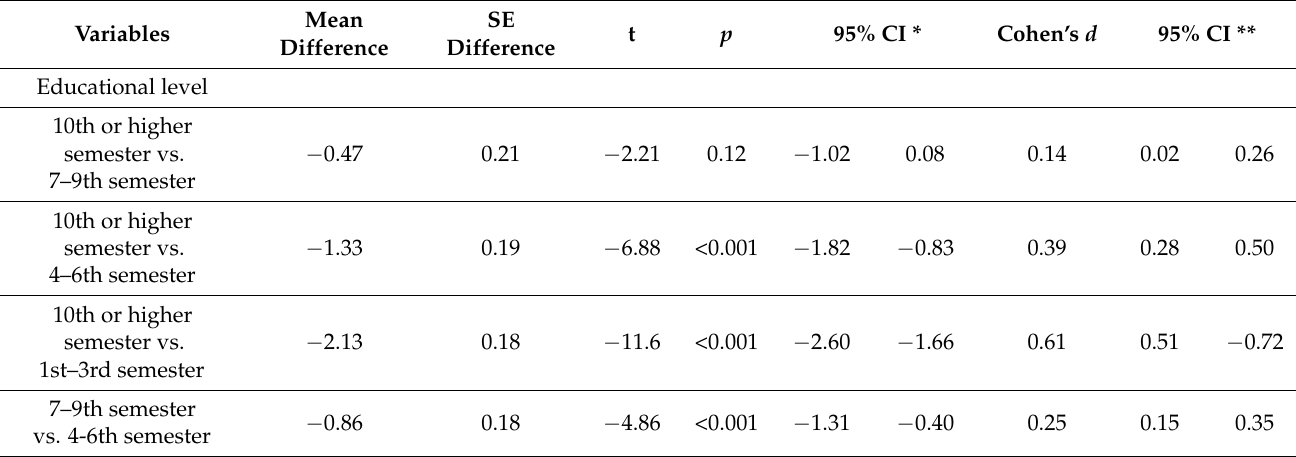
Table 2. Effect size and statistical significance for Tukey post-hoc analysis within demographic